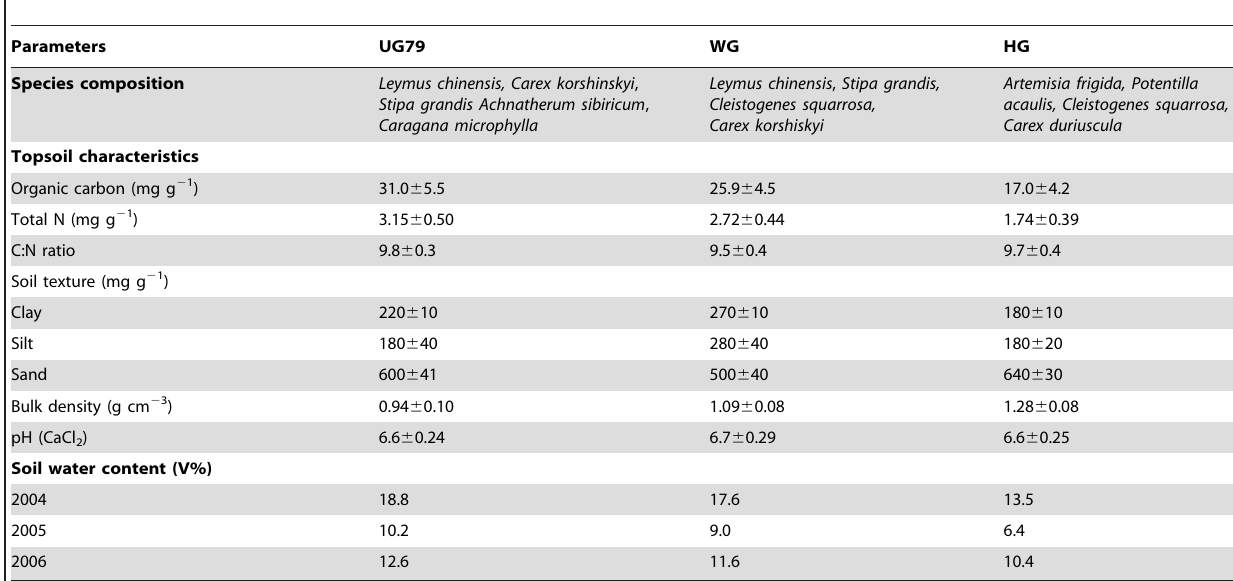
Table 1. Species composition, topsoil characteristics (0–4 cm depth, except texture 0–10 cm depth) and average growing season soil water content of Inner Mongolia typical steppe under different land use